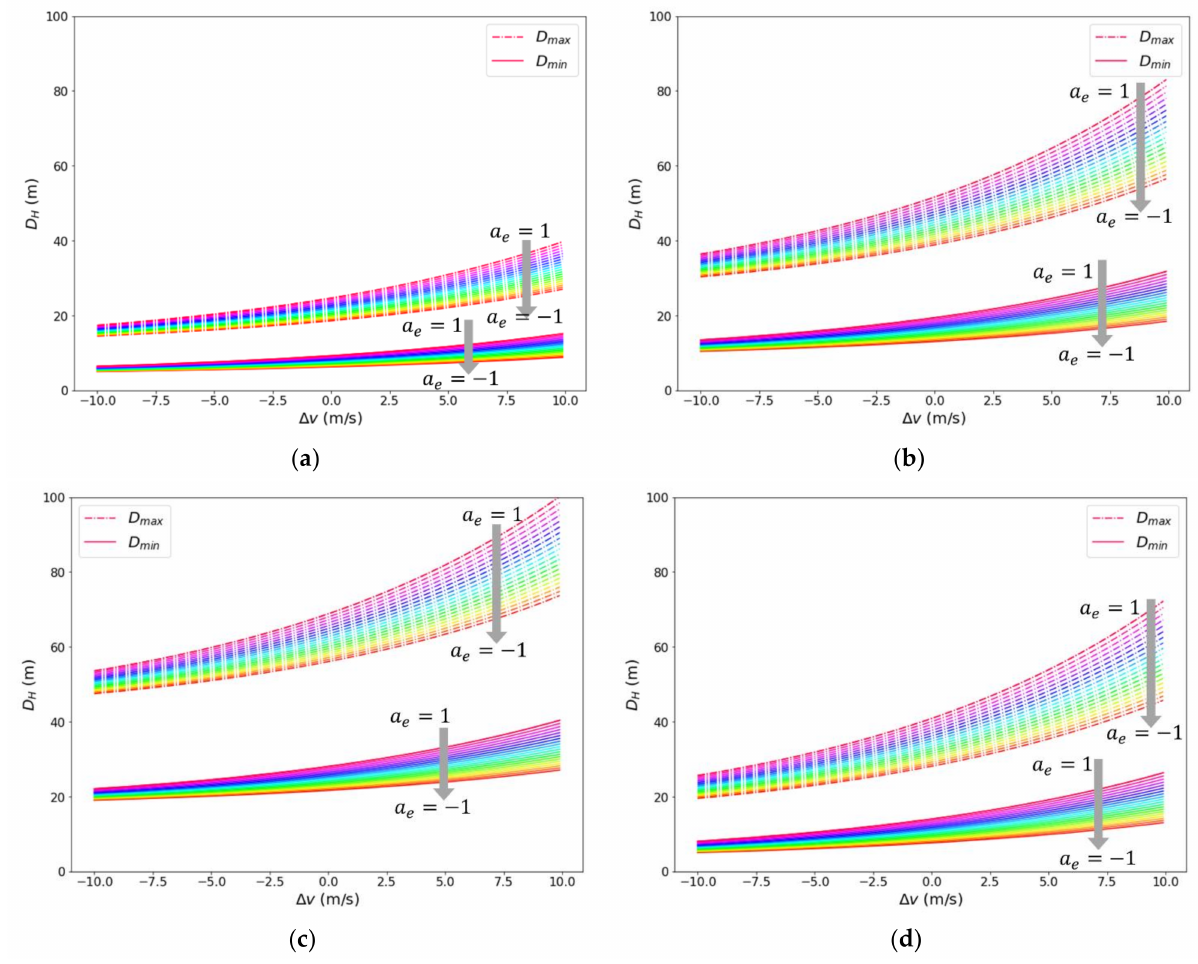
Figure 7. Critical distances D max and D min in a rear-end crash: ( a ) v f = 10 m/s, a f = 0 m/s 2 ; ( b ) v f = 20 m/s, a f = 0 m/s 2 ; ( c ) v f = 20 m/s, a f = − 2 m/s 2 ; ( d ) v f = 20 m/s, a f = 2 m/s 2